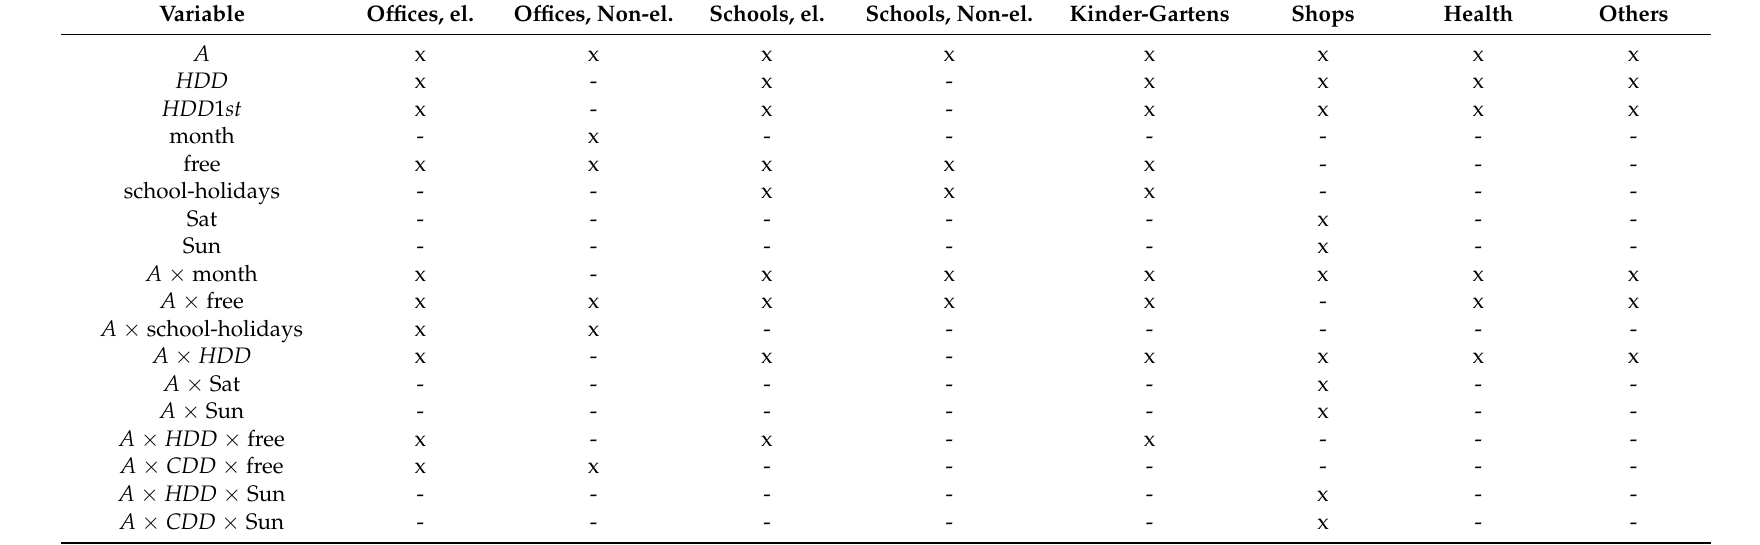
Table A3. Explanatory variables, service sector models, hourly electricity